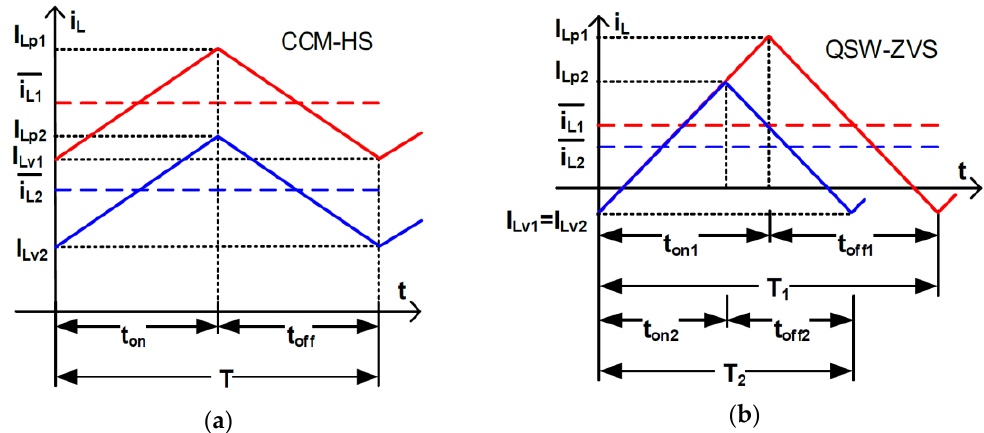
Figure 2. Ref. [13] Inductor current waveform for two different power levels. ( a ) CCM-HS and ( b ) QSW-ZVS.